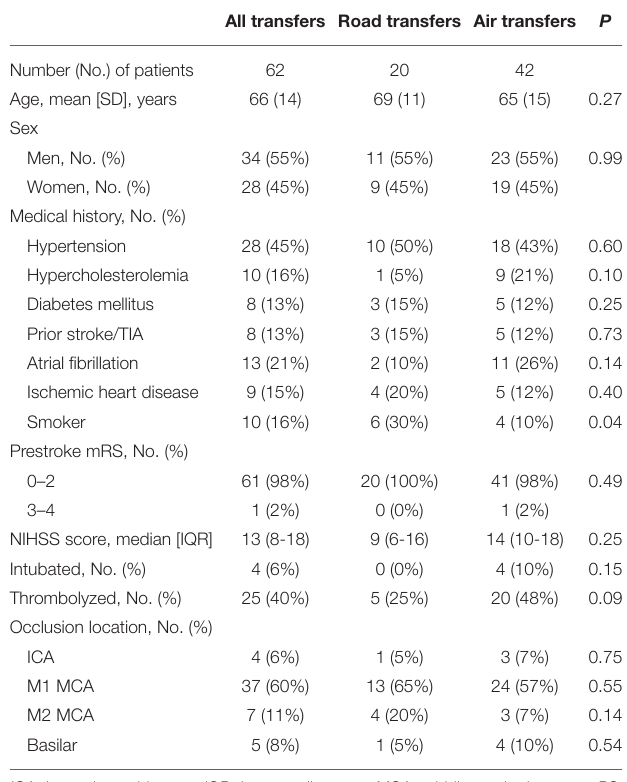
TABLE 1 | Baseline characteristics of different groups.